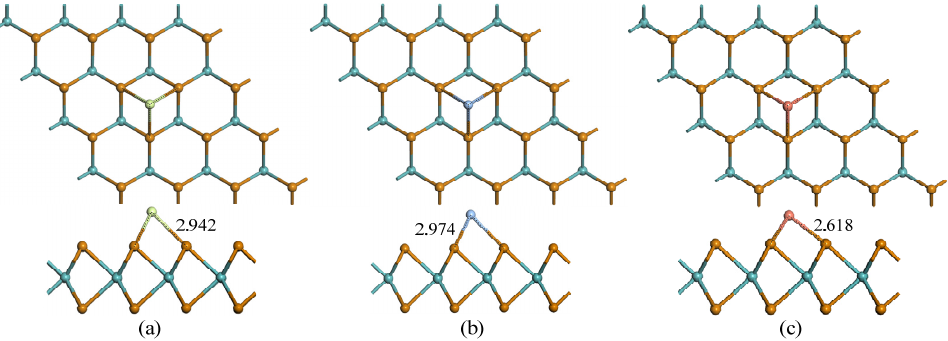
Figure 2. Top view and side view of: ( a ) Au-MoTe 2 ; ( b ) Ag-MoTe 2 ; ( c ) Cu-MoTe 2 . The unit is Å.